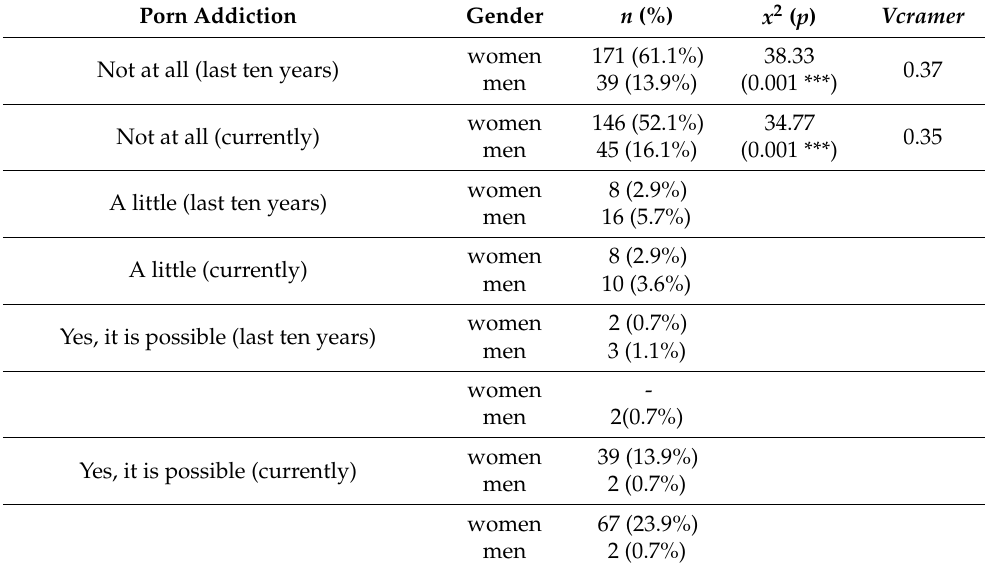
Table 6. Evaluation of Porn Addiction according to